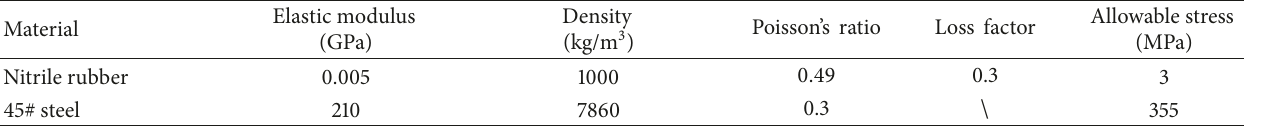
Table 1: Material